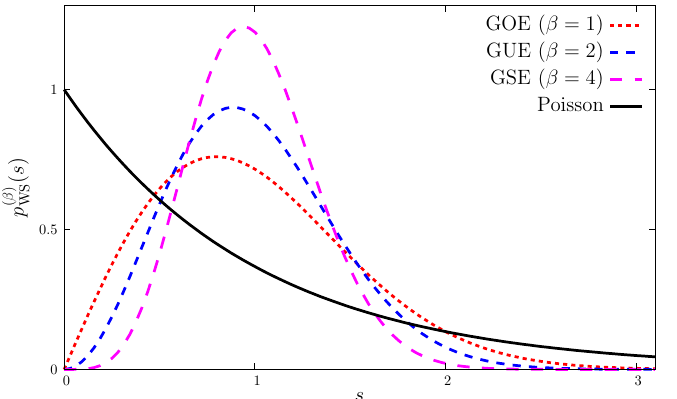
Figure 5. Wigner surmise for the various symmetry classes. The exponential distribution for Poisson statistics is also